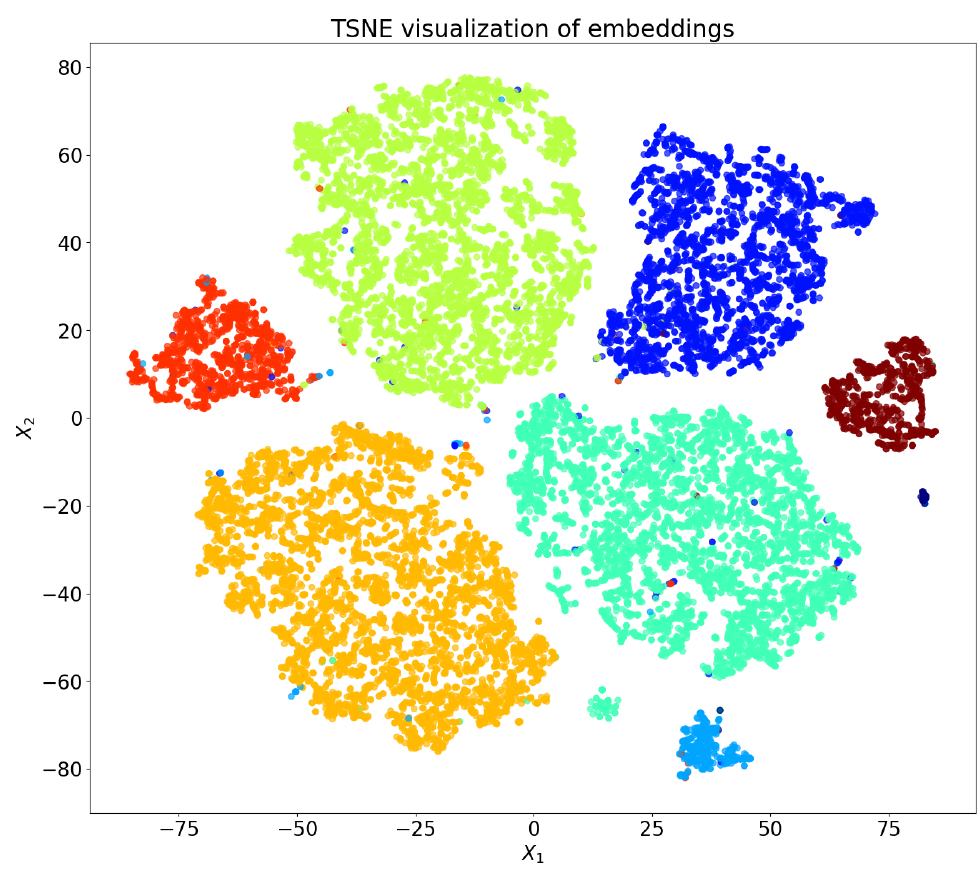
Figure 7. T-SNE visualization of the embedding matrix generated with the language-agnostic BERT sentence embedding